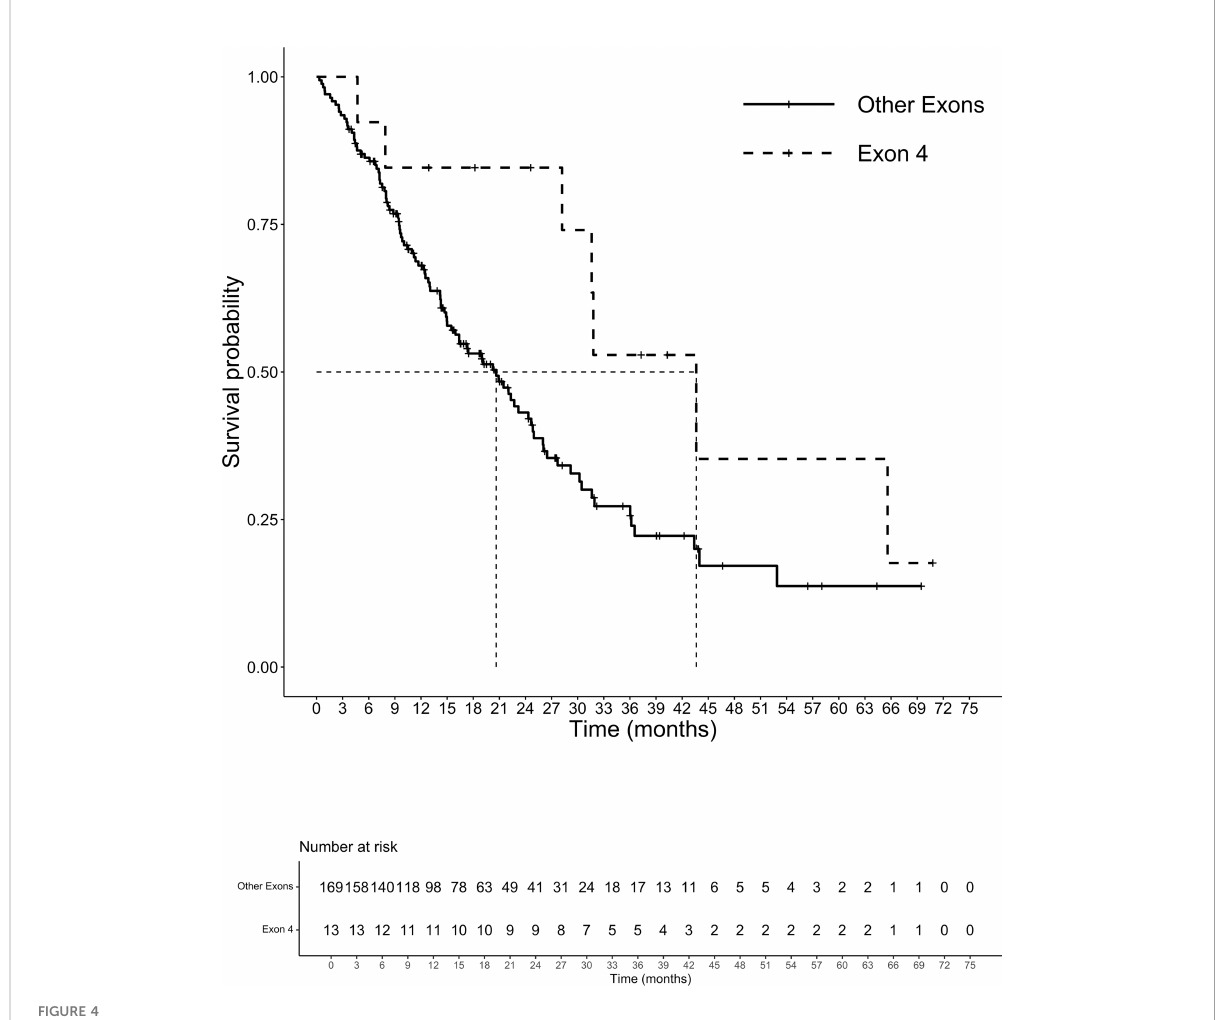
FIGURE 4 Overall survival exon 4 vs other